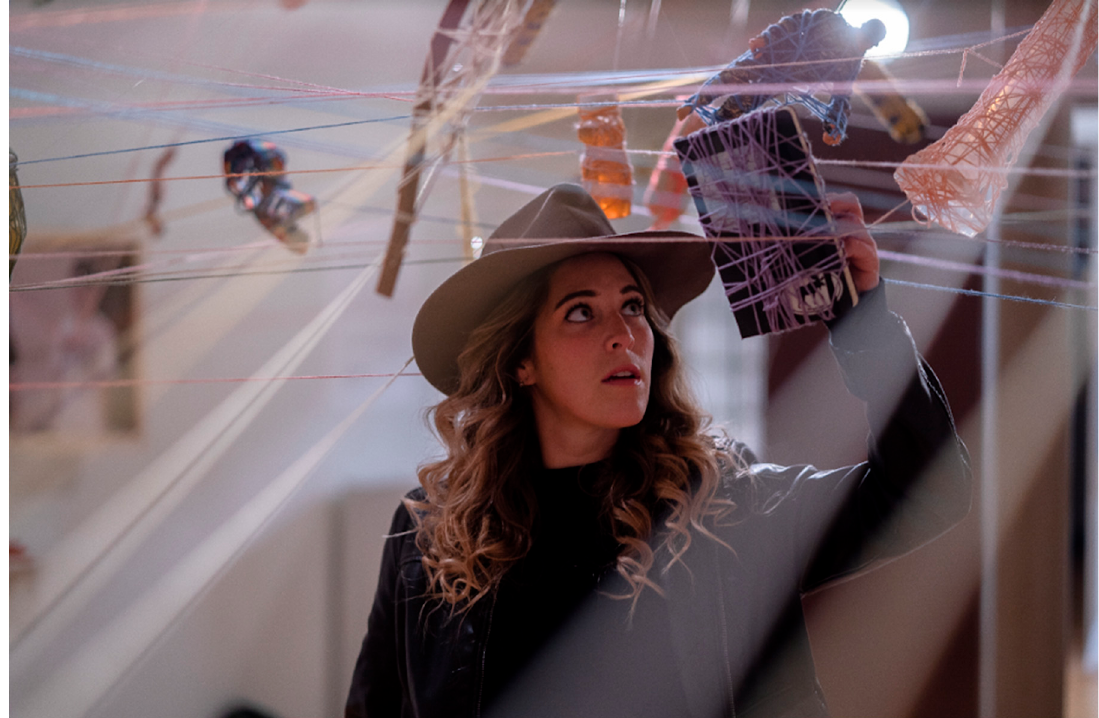
Figure 9. Megan Altieri inspecting Becoming Us , 2018 (Photo graciously provided by Megan Altieri).